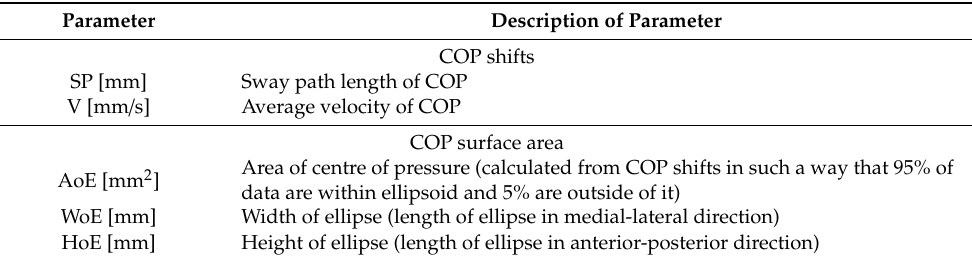
Table 1. Specification of posturographic measures analysed. COP = centre of